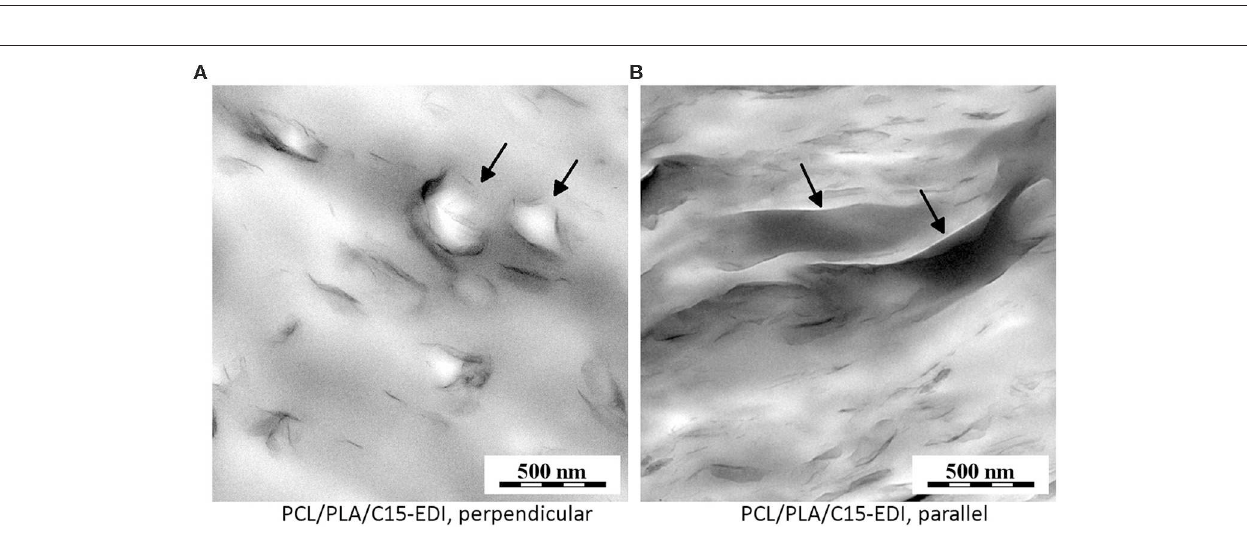
FIGURE 3 | TEM micrographs showing filler dispersion in PCL/PLA/C15-EDI composite: (A) perpendicular to the melt flow and (B) parallel with the melt flow. Black arrows show that the C15 agglomerates tended to envelope PLA particles, which were somewhat elongated in the direction of melt